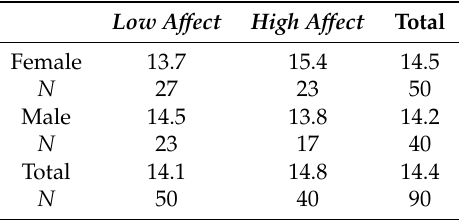
Table 2. Affect score by treatment and